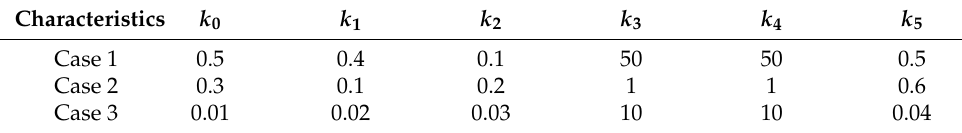
Table 1. Systematic characteristics in three cases.